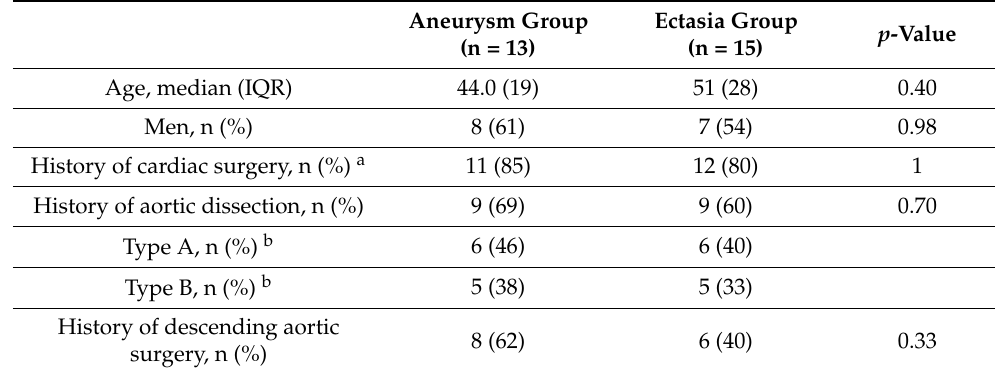
Table 2. Baseline characteristics of patients presenting with PNAL at